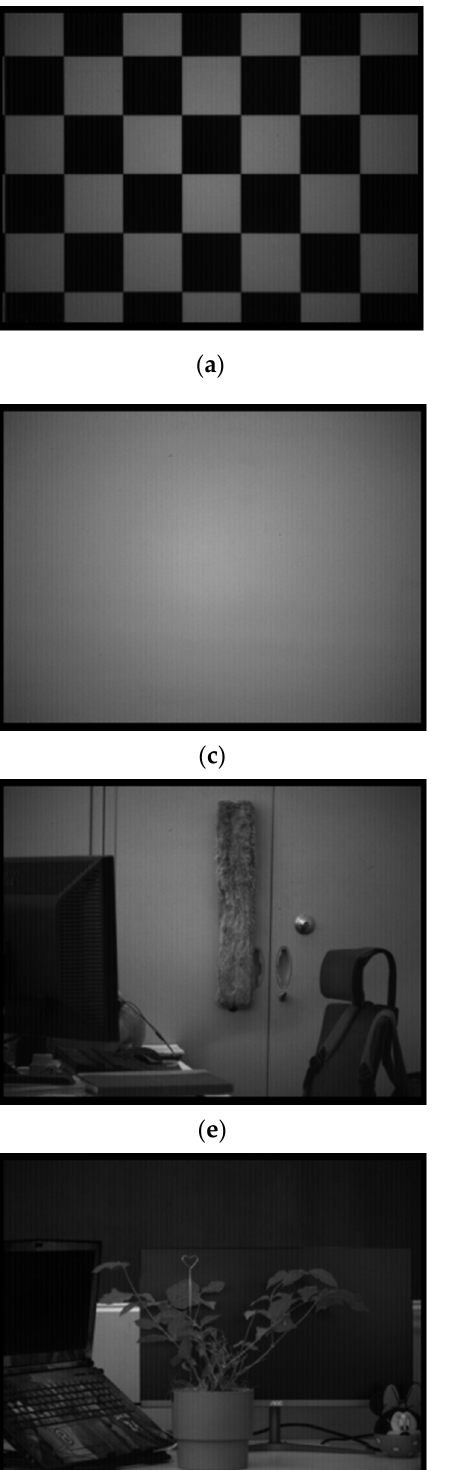
( b ) Figure 10. Results of lens distortion correction. ( a ) Before calibration and ( b ) after calibration. The internal parameters and the distortion coefficients are shown in Table 2. Table 2. Lens parameters. Internal Parameters